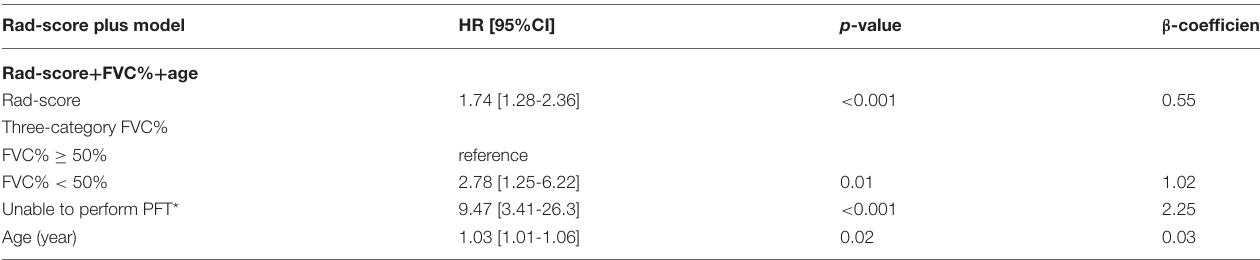
TABLE 4 | Results of multivariable Cox regression analysis based on Rad-score.